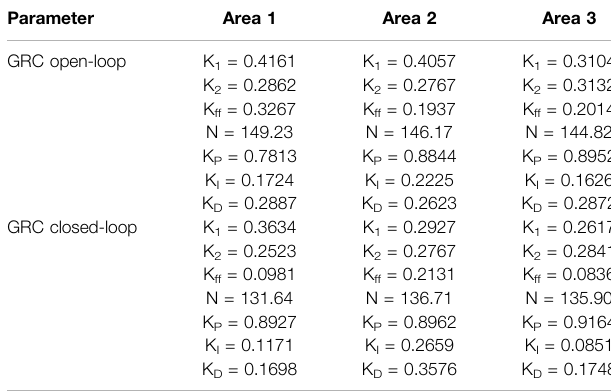
TABLE 5 | Optimal gains of the 3DOF-PID controller found using the WCA algorithm for the three-area thermal system.